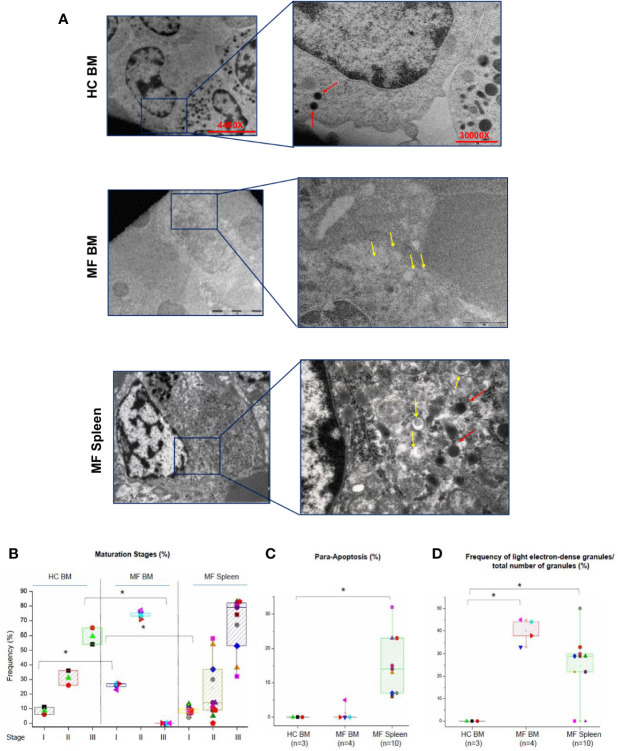
The bone marrow (BM) from MF patients contains mostly immature megakaryocytes while megakaryocytes in MF spleen are mostly mature. (A) Representative ultra-thin sections of Stage II megakaryocytes from BM of one healthy control (HC) and one MF patient and from a Stage III megakaryocyte from the spleen of one additional patient. Representative megakaryocytes are presented on the left (magnification 4,400×) and detail of their cytoplasm shown on the right to highlight the electron-density of their granules (magnification 30,000×). Light and heavy electron-dense granules are indicated by yellow and red arrows, respectively. Scale bars = 5 and 1 μm, as indicated. (B) Frequency of megakaryocytes at different stages of maturation (as percent of viable megakaryocytes) and (C) in para-apoptosis (as percent of total megakaryocytes) in BM and spleen from multiple MF patients and HC. *p < 0.05 with respect to the corresponding value in HC. (D) Frequency of light electron-dense granules with respect the total number of granules detected in megakaryocytes from HC and MF patients. *p < 0.05 with respect to the indicated experimental group. In B–C, results are presented as Median (lines across boxes), 25–75% inter-quartile range (boxes), and maximum and minimum values (the end of the vertical line across the boxes) (for further details see legend of Figure 1). The number of subjects included in each experimental group is indicated by n. The total number of megakaryocytes analyzed is 59 for HC BM and 215 and 430, respectively, for BM and spleen from MF patients. Results with spleen from HC are not reported because megakaryocytes are seldom detected in this organ.